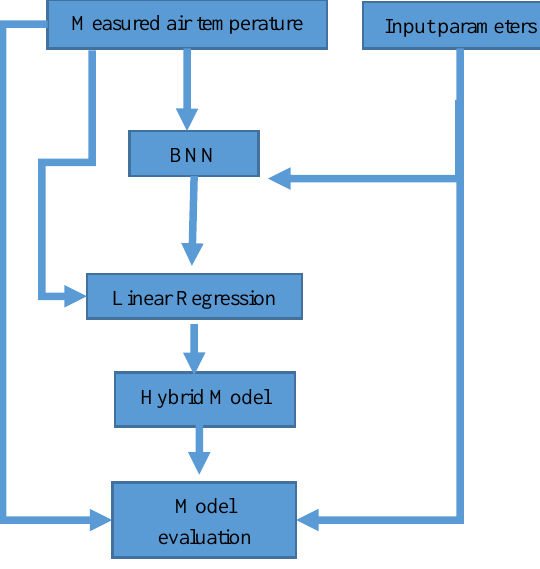
Figure 5. The flowchart of the proposed Hybrid Method 3.